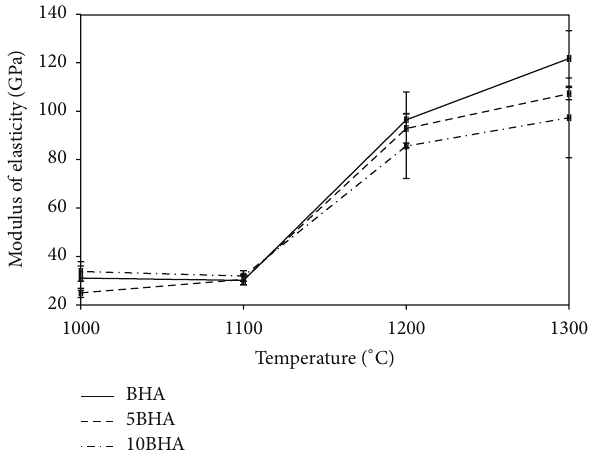
Figure 10: Variation of microhardness of BHA, 5BHA, and 10BHA composites at different sintering